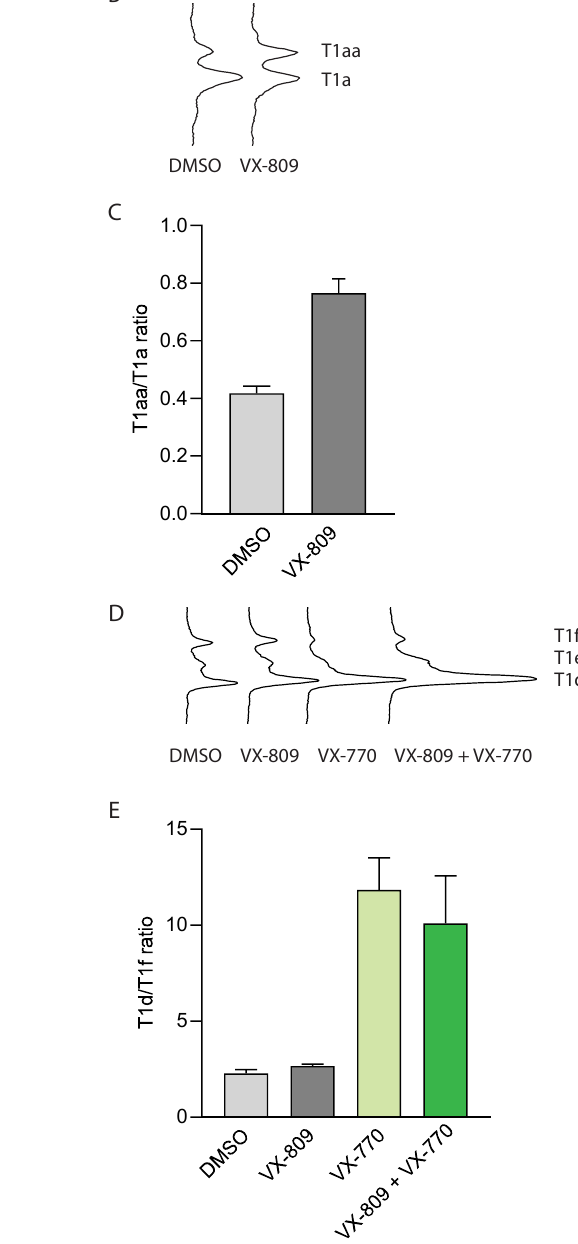
Figure 3. Conformation of CFTR is sensitive to the binding of modulators ( A ) HEK293T cells expressing wild-type CFTR were radiolabeled for 15 min and chased for 0 or 2 h, as in Figure 2. Where indicated, VX-809 (3 µ M) or VX-770 (3 µ M) were added during starvation, pulse, and chase. CFTR was analyzed as in Figure 2. The top panel shows undigested CFTR and the lower panels show domain-specific fragments immunoprecipitated after digestion with 25 µ g/mL or (where indicated) 100 µ g/mL proteinase K. Representative gel of three experiments. ( B ) Lane profiles of immunoprecipitated TMD1 fragments T1a and T1aa, after 0 h chase and 100 µ g/mL proteinase-K digestion. ( C ) Quantification of T1a and T1aa fragment ratios at 0 h chase. Band intensities were quantified using ImageQuant. ( D ) Lane profiles of immunoprecipitated TMD1 fragments T1d, T1e, and T1f after 2 h of chase. For an explanation of abbreviations see the legends of Figures 1 and 2. ( E ) Quantification of T1d and T1f fragment profiles as in ( C ). Bars show standard deviations of n =